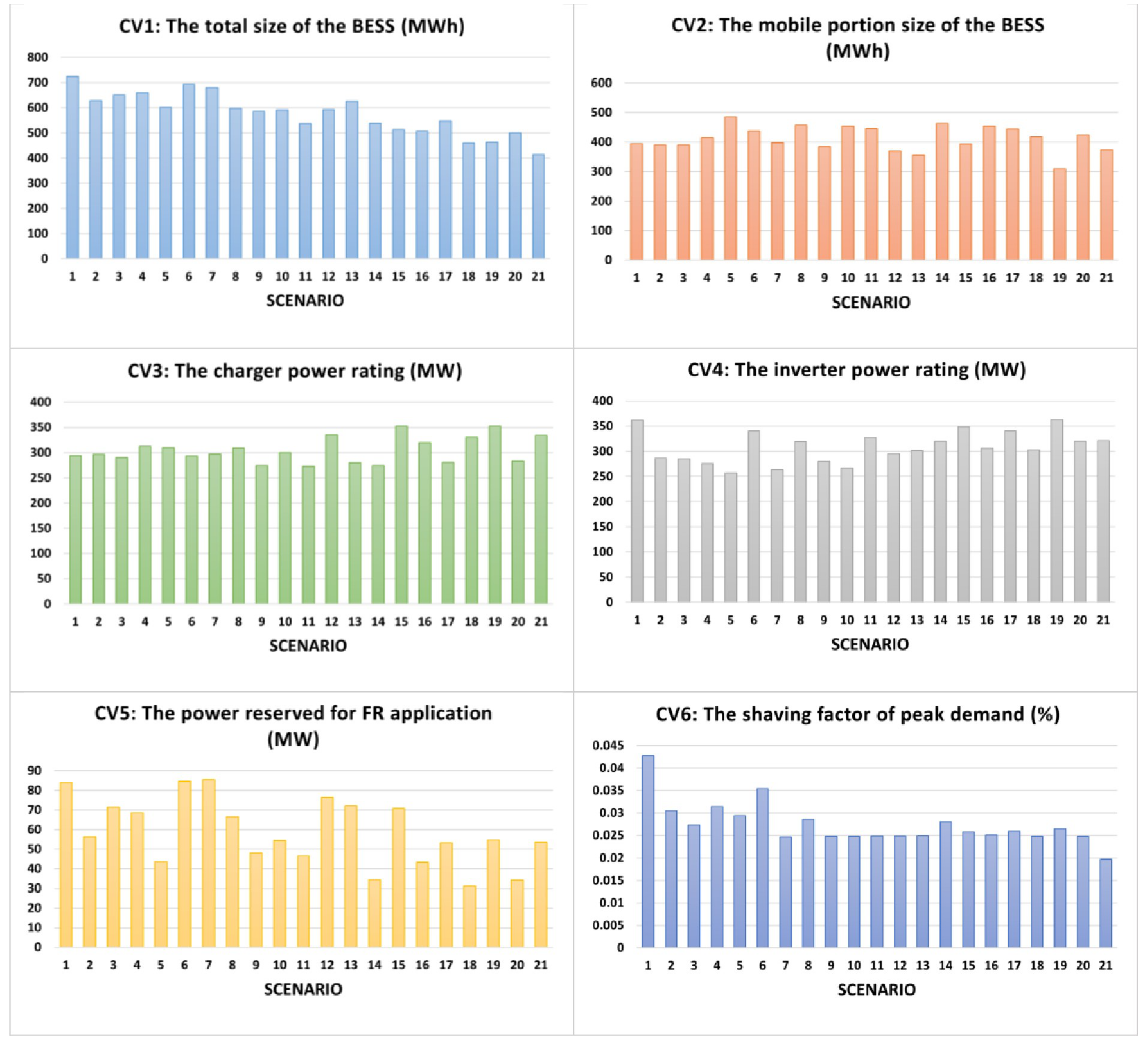
Fig 12. Optimal solutions of the six control variables with 21 weight factors from 0 (Scenario 1) to 1 (Scenario 21) in step of 0.05 under AC priority